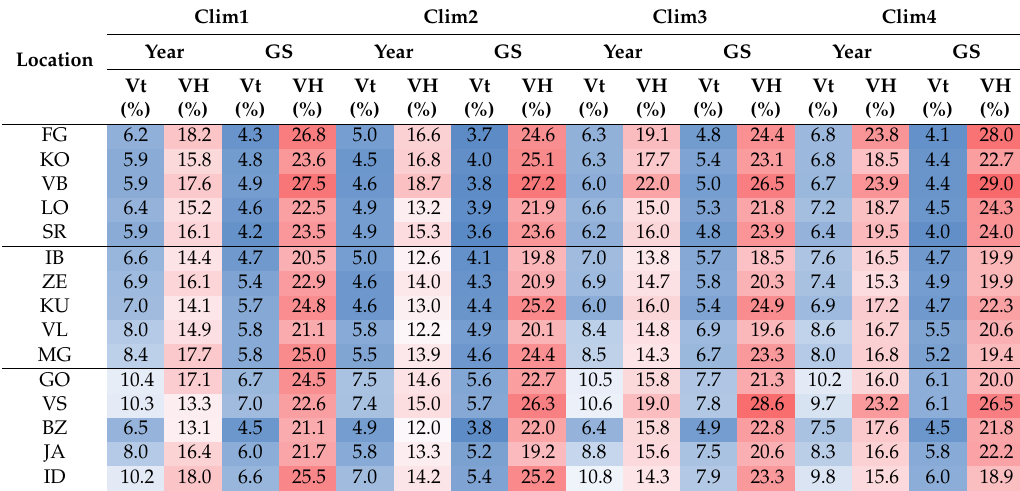
Table 3. Coefficient of variation of temperature (Vt) and precipitation (VH) for the selected climatological periods (GS—growing